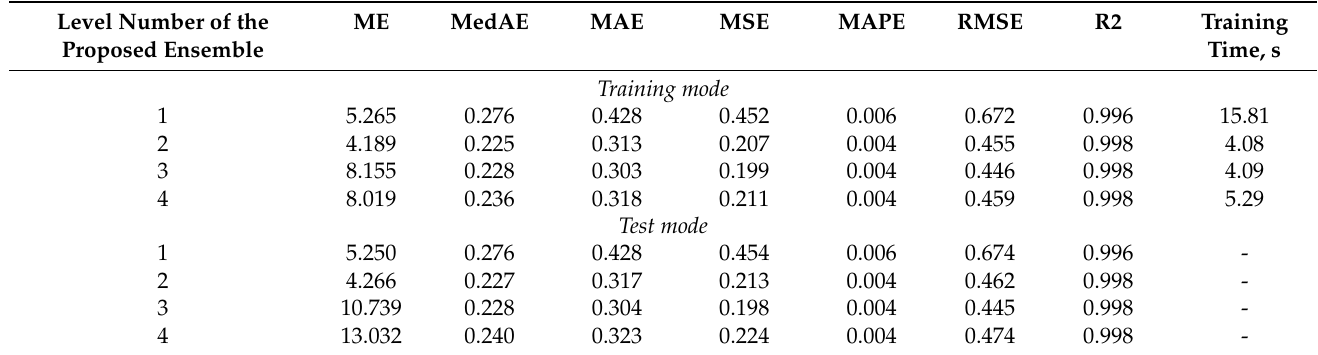
Table 4. Performance indicators for a different level number of the proposed